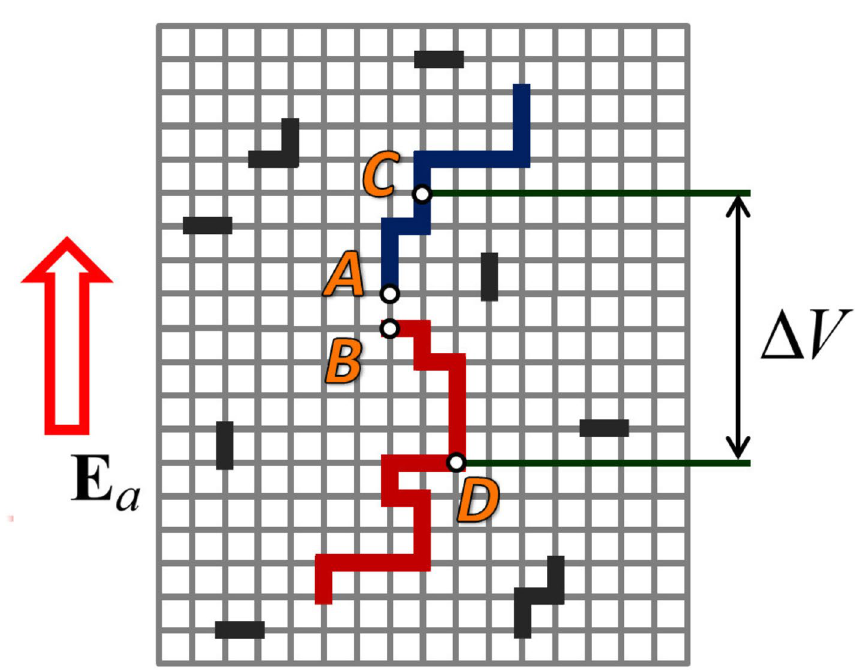
Figure 3. 2D dielectric lattice with some conducting links and groups of interconnected conducting links (shown by thicker lines) in a uniform electric field E a . The conducting links, particularly their clusters oriented primarily along E a (see the blue and red clusters whose centers (origins) are labeled C and D, respectively), can significantly enhance the electric field near cluster ends. This may lead to electrical breakdown at cluster ends (for example, and most likely, between points A and